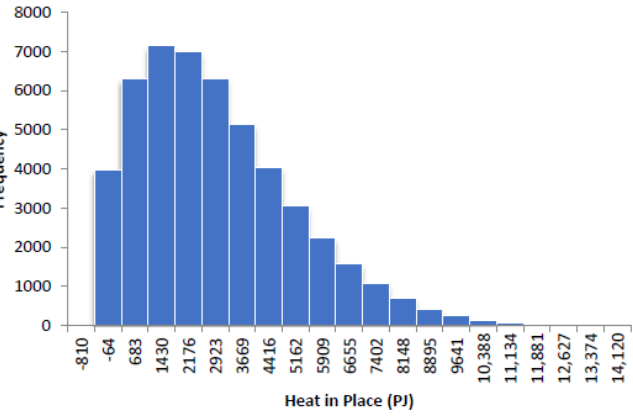
Figure 11. Heat-in-place probability distribution for well doublets—syn-rift phase.